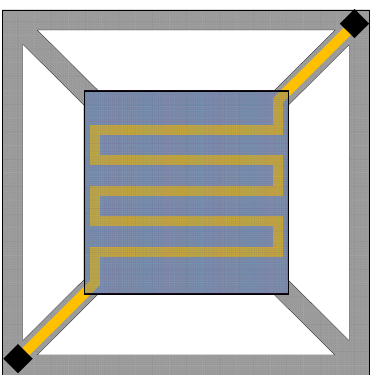
Figure 3. CCLC model.